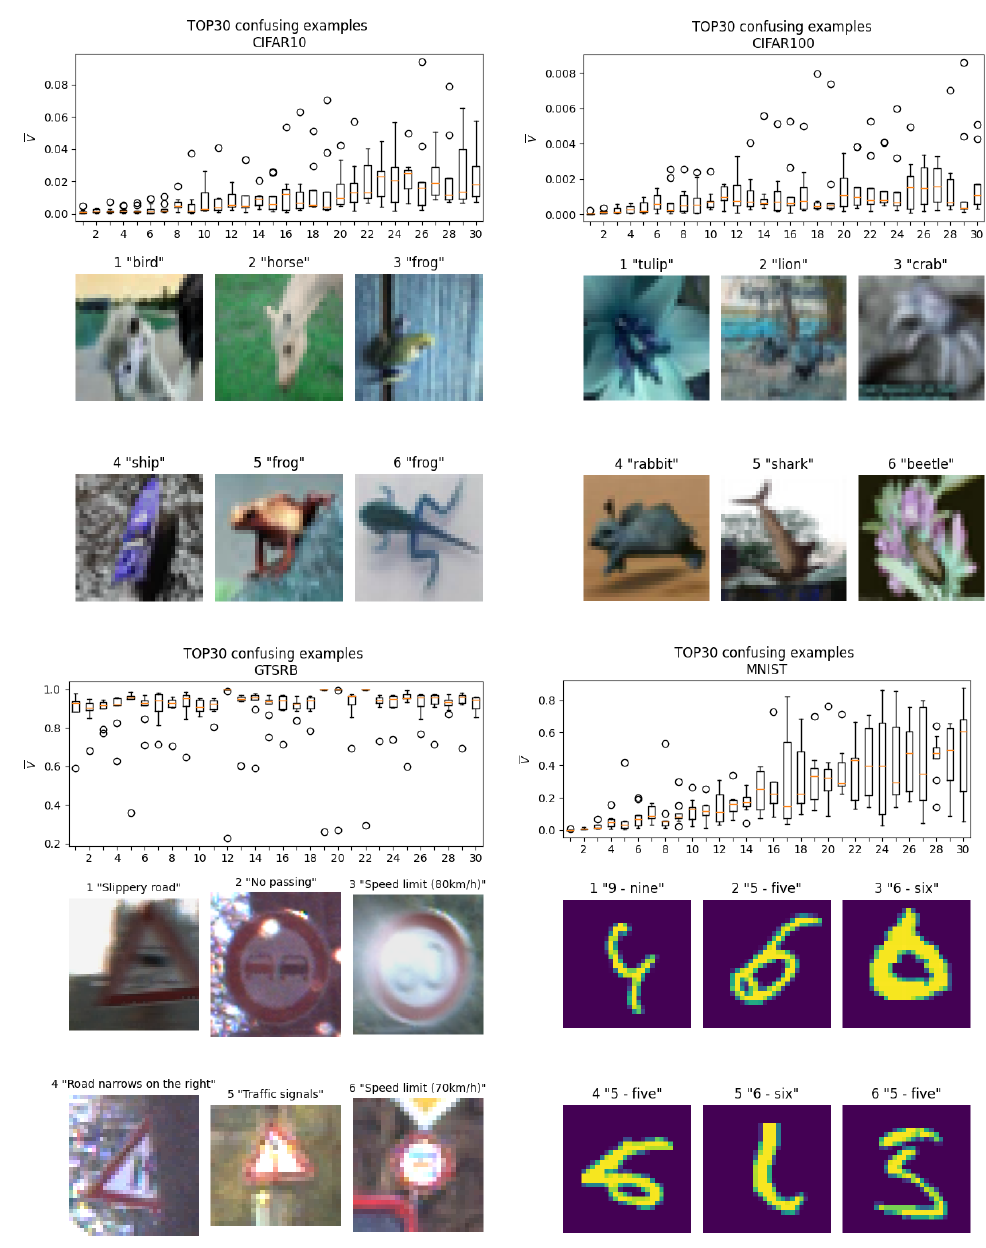
Figure 5. Boxplots of V , the classification output averaged over all 200 epochs and all eight utilized DNN architectures, for the 30 most difficult-to-classify images within each data set. The six most difficult images are presented below each